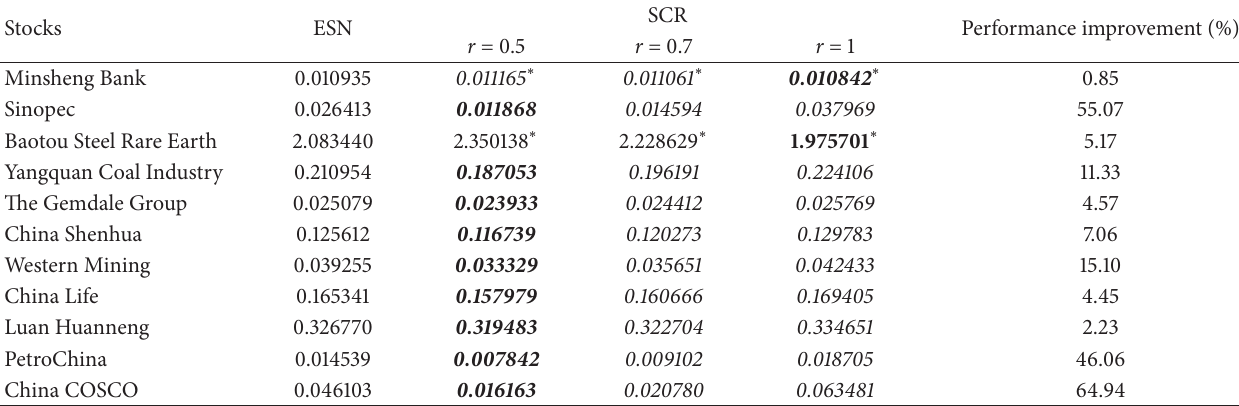
Table 3: Comparative results of ESN and SCR by average forecasting accuracy